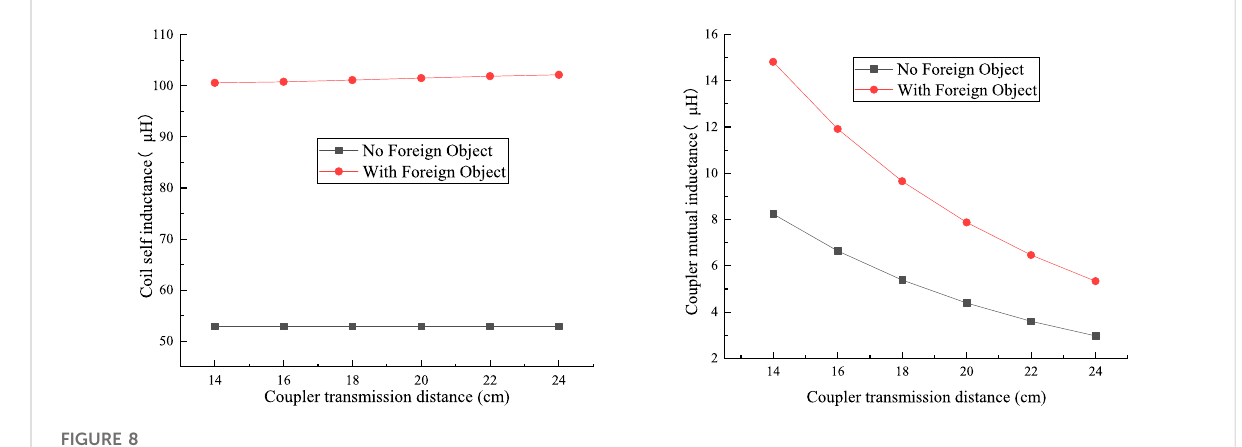
FIGURE 8 In fl uence of the changes in coupler transmission distance on parameters.